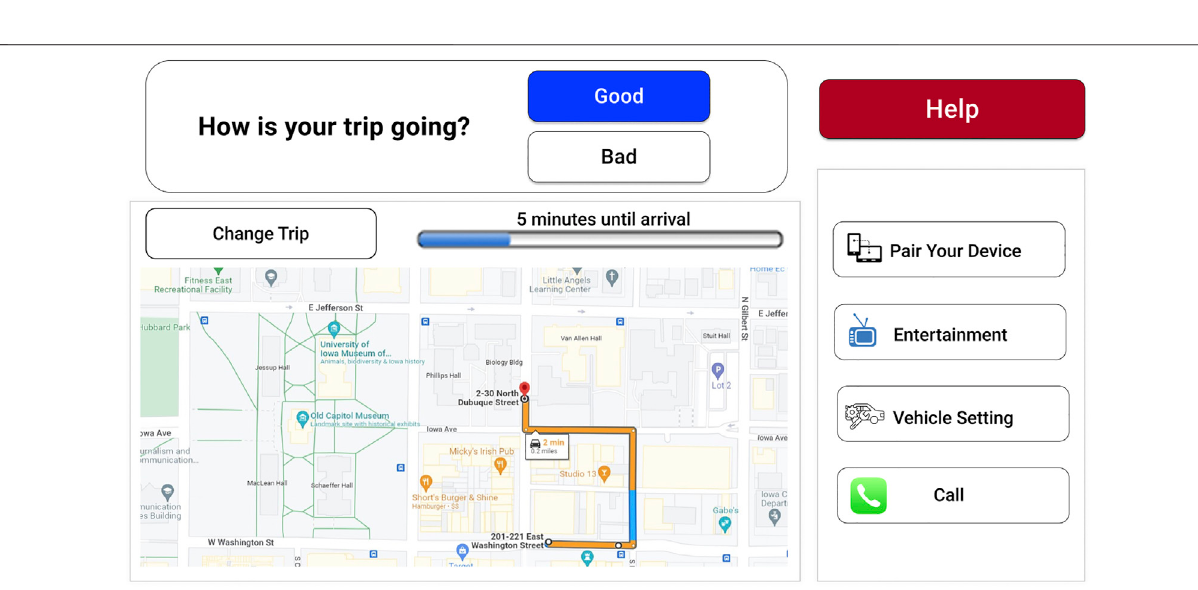
FIGURE 6 | Prototype of the health and status checking